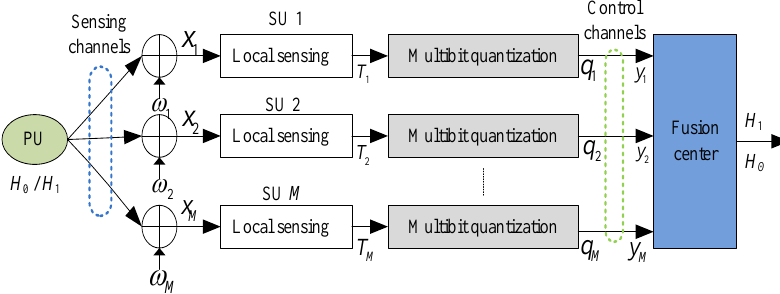
Figure 1. The structure of quantization-based cooperative spectrum sensing (CSS) system with M secondary users (SUs) and a fusion center (FC).